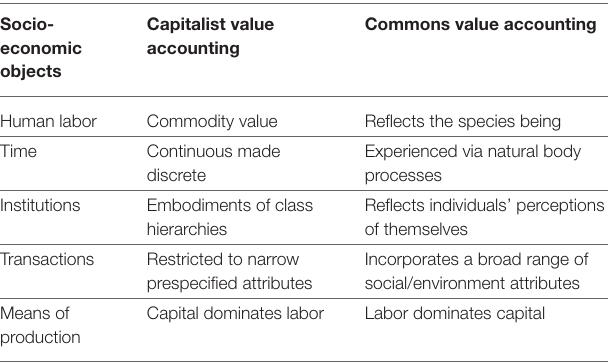
TABLE 2 | Socio-economic objects within capitalist value accounting compared to commons value accounting. Socio-